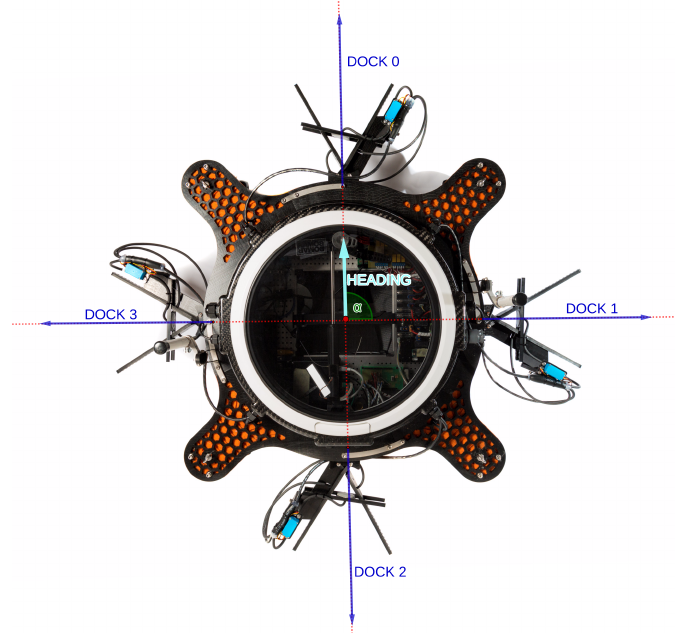
Figure 12. aPad vehicle viewed from above with docks marked in indexing order. Example angle α highlighted for dock with index